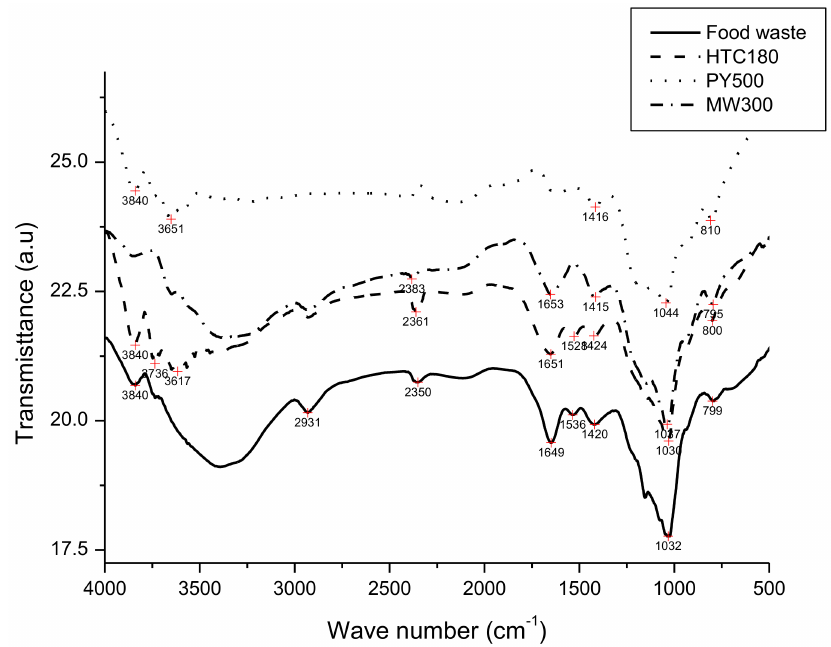
Figure 2. FT-IR spectra of food wastes mixture, HTC180, PY500, and